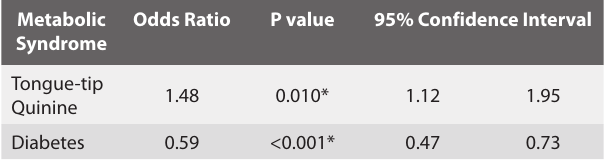
Table 5. Multivariate analyses of tongue-tip quinine taste dysfunction versus metabolic syndrome.